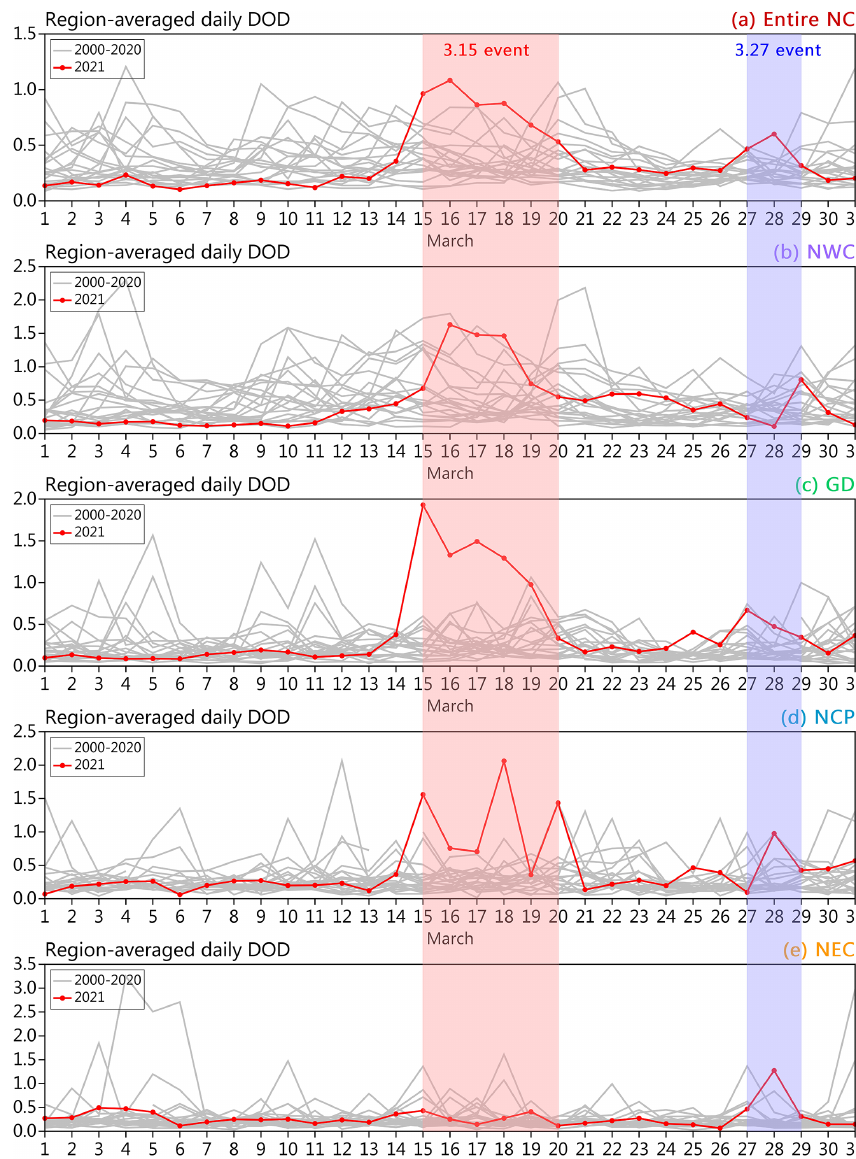
Figure 14. MODIS-retrieved daily mean DOD for March 2021 (thick lines with red dots) in comparison to the 2000–2020 climatology (the year-to-year fluctuation range of daily DOD is represented by the thick gray line) in five regions, as defined in Fig. 13c. The days covered by the 3.15 and 3.27 events are marked in red and blue shading,